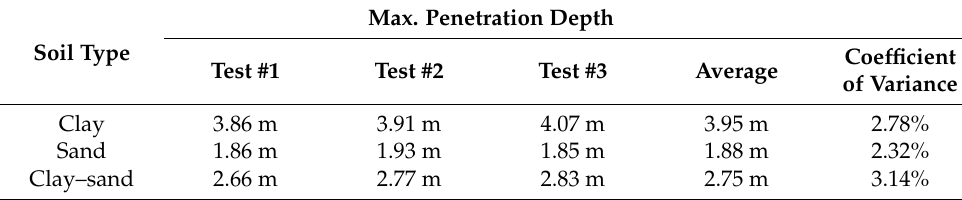
Table 2. Field verification test results for soil penetration of anchor pile.